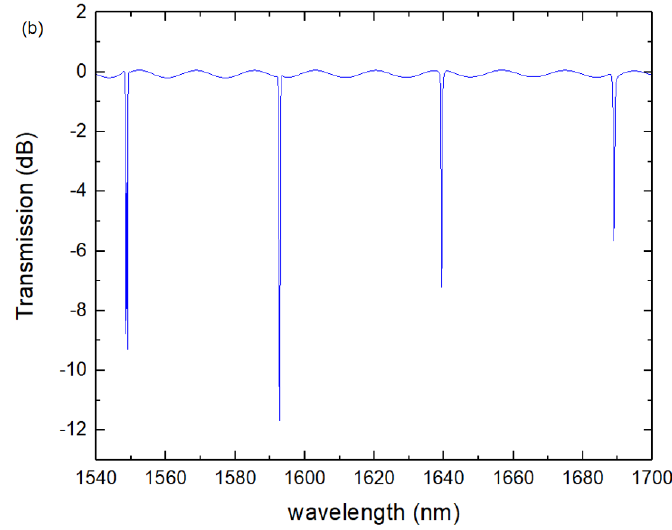
Figure 9. Output spectrum with only one side grating ( a ) inside only ( b ) outside only.